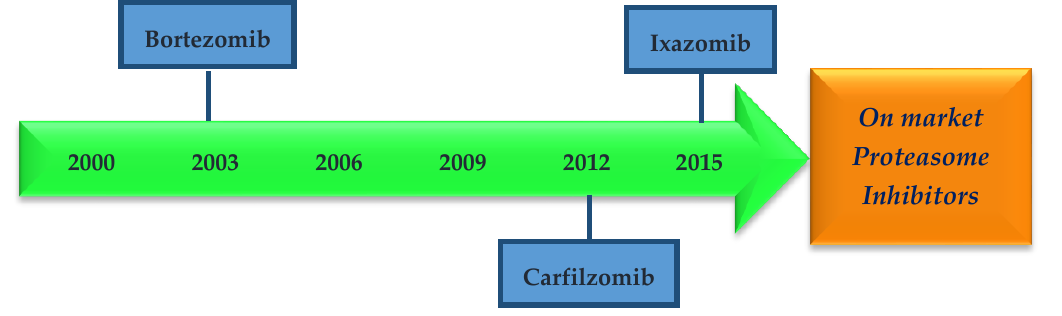
Figure 4. Timeline of on market proteasome inhibitors approved by the FDA.